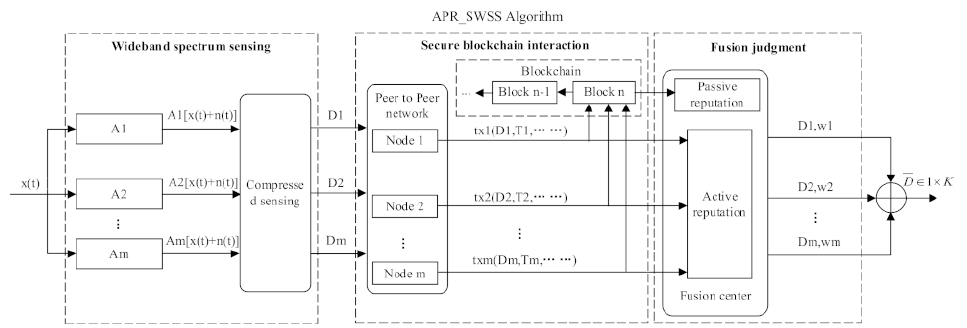
Figure 4. Overview of the framework of APR_SWSS